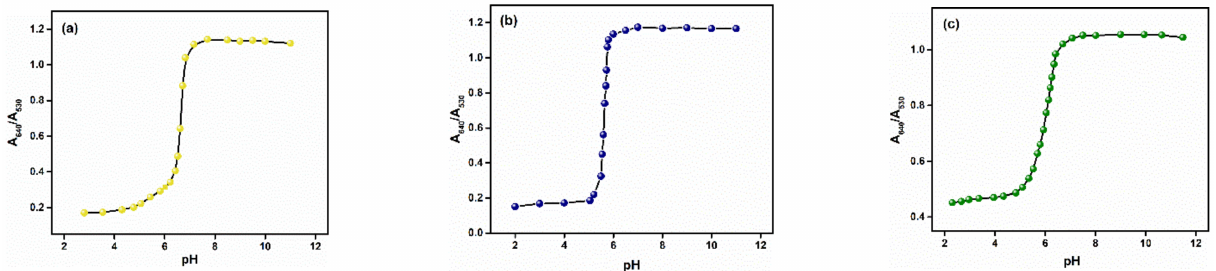
Figure 5. The changes in UV–vis spectra of chemosensors S1 ( a ), S2 ( b ) and S3 ( c ) in MES buffer solution (10 mM 25 ◦ C) in the pH range of 2–12.